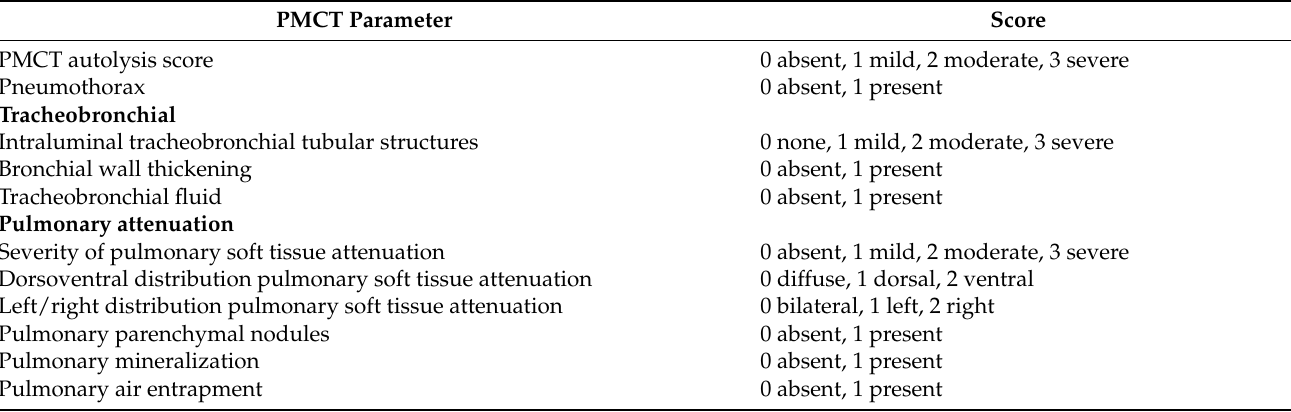
Table 1. PMCT pulmonary